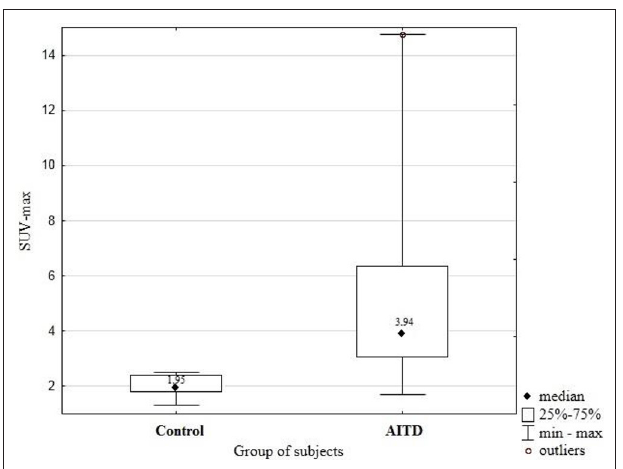
FIGURE 1 | Difference of SUV-max between group of patients with AITD and control group subjects.